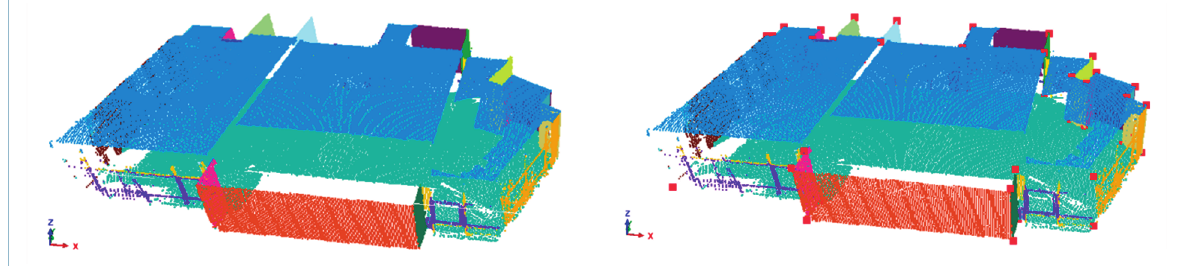
Figure 5. The segmented regions of an indoor scene are individually shown in different colors ( left ); Once regions are identified and intersected, boundary points defining each surface (red color) are obtained ( right ).